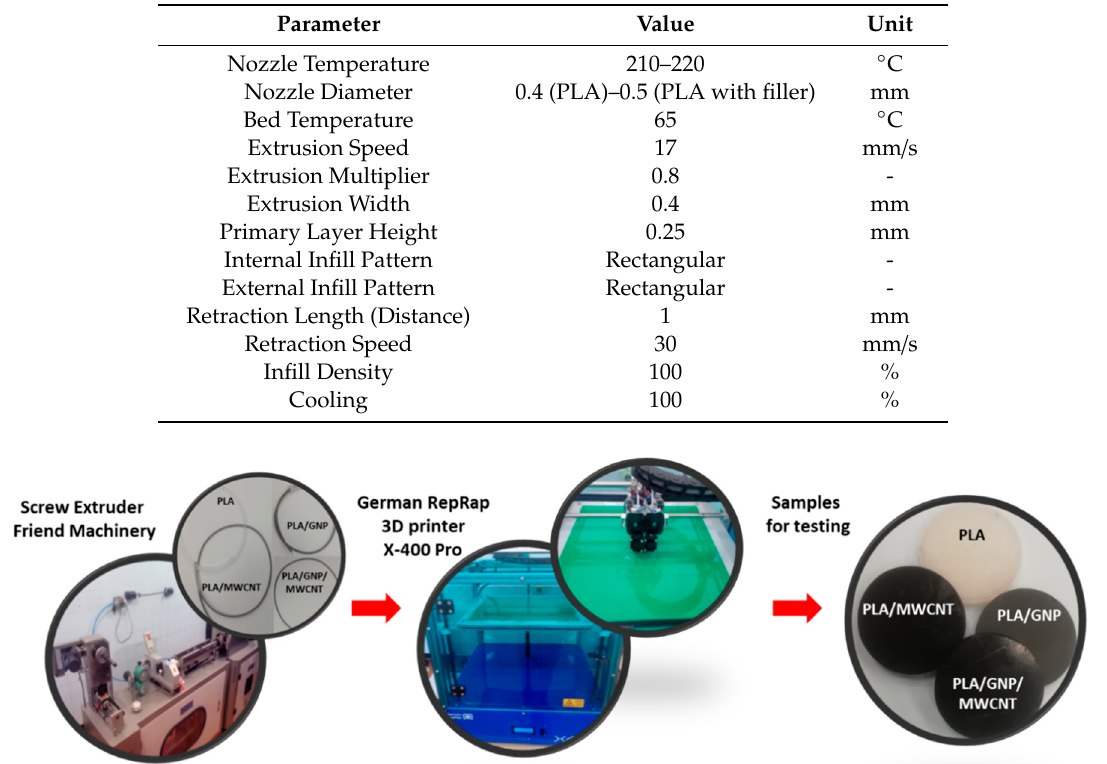
Table 1. Printing parameters setting.